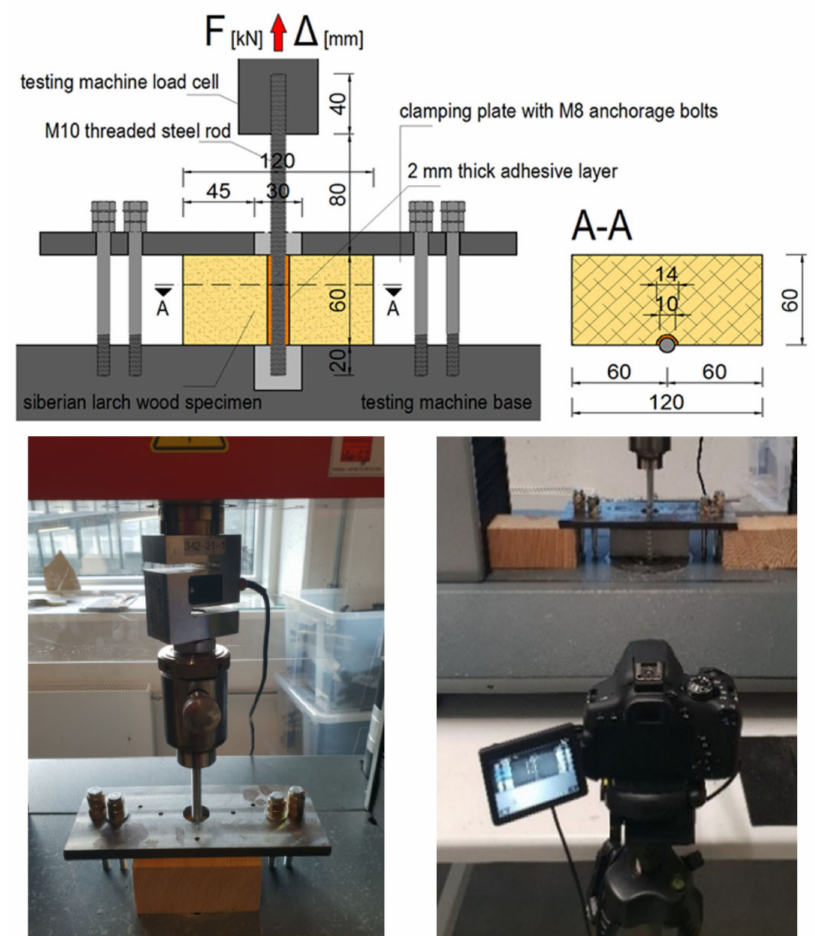
Figure 3. Pull-out test set-up: schematic view and details (nominal dimension in